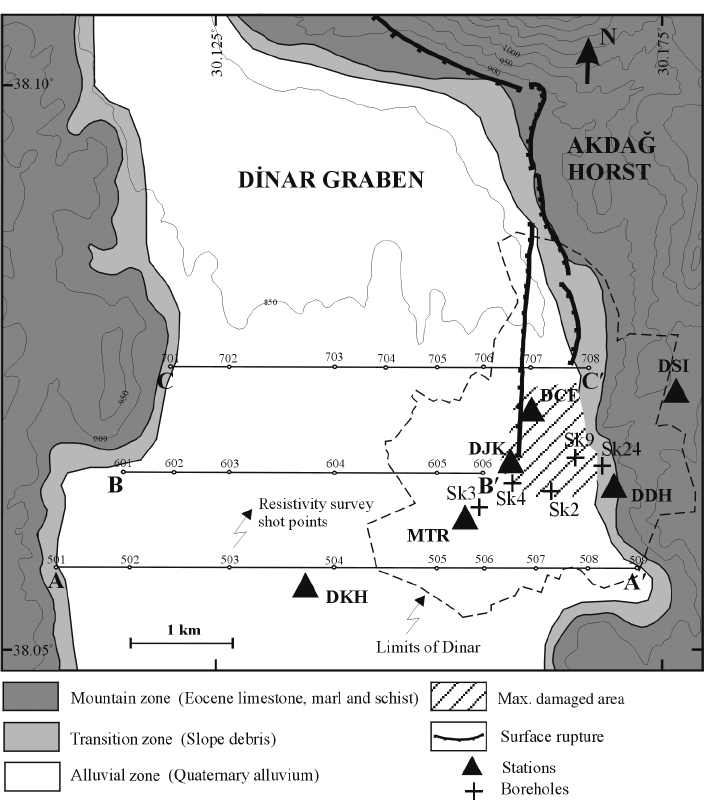
Fig. 2. Geological map of the Dinar Graben and its vicinity. Triangles indicate the recording stations used in this study. A-A ′ , B-B ′ and C-C ′ are the locations of resistivity profiles shown in fig. 3. of the boreholes shown in fig.